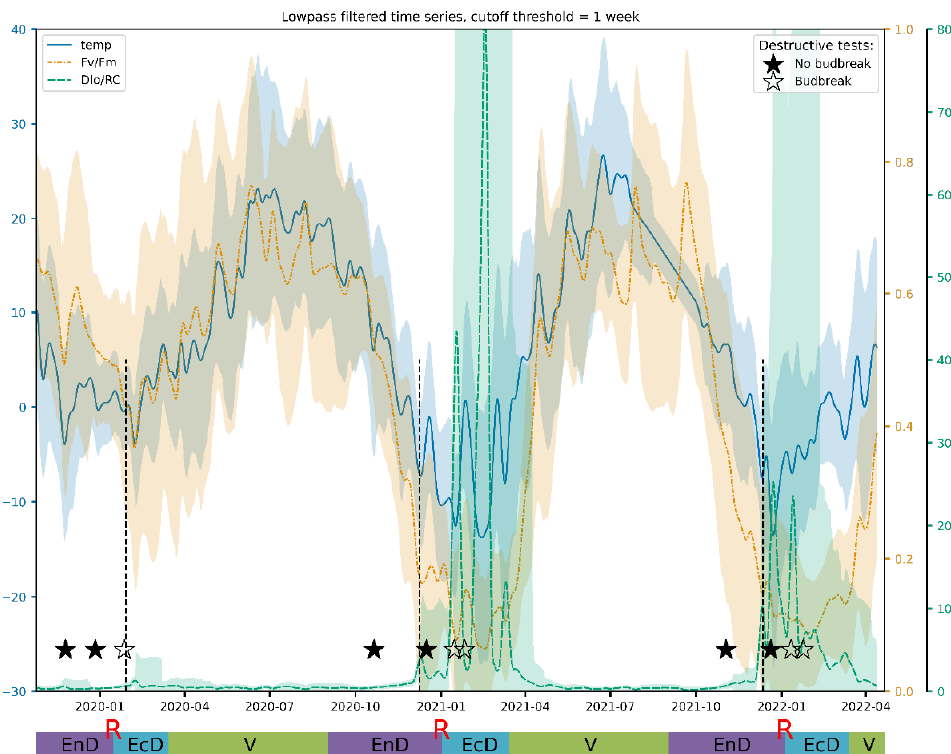
Figure 5. The time-courses of air temperature and the spectral power of the PS II Qy (Fv/Fm) and thermally dissipated energy flux (DI 0 /RC) variations with the period of one week (lowpass filtered value ± 2 × STD). The plots and the corresponding Y -axis are drawn in same color. For meaning of the annotations, see the legend to Figure 4.